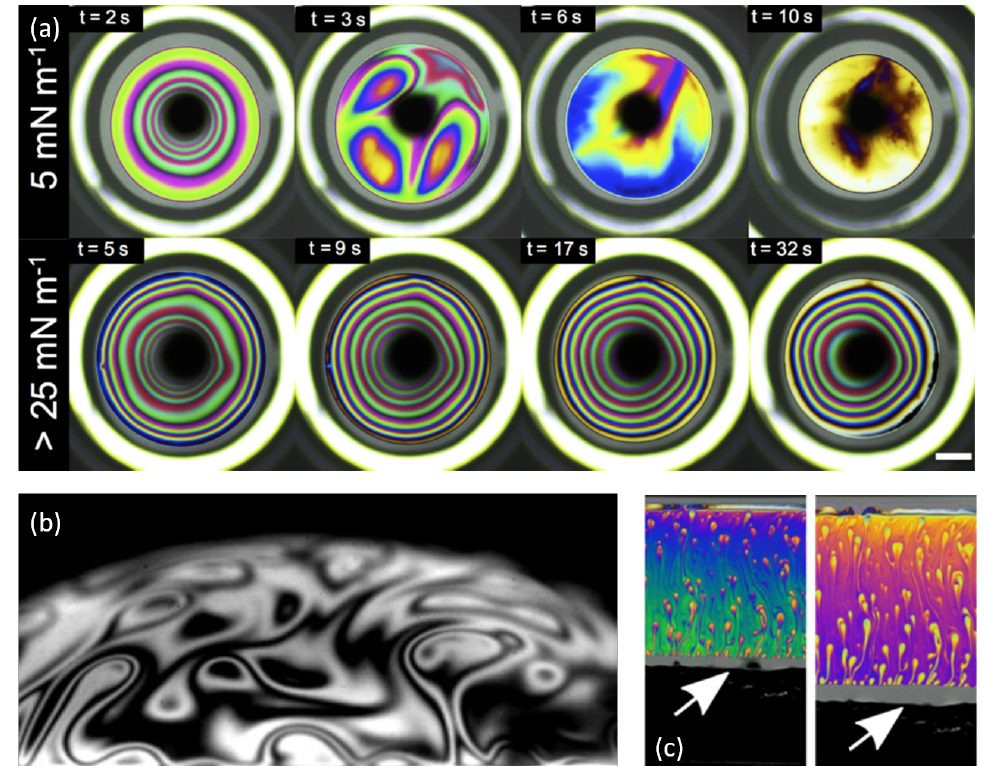
Figure 5. ( a ) Top view of a bubble thinning along time. The bubbles are stabilised by DPPC. The experi- ment allows to control accurately the surface pressure, which is set to 5 mN m − 1 (top) or to 25 mN m − 1 . The former exhibits some loss of axisymmetry. Figure adapted from reference [42]. ( b ) View of the marginal regeneration patches in the meniscus of a surface bubble. Figure adapted with authorization from reference [21]. ( c ) Observation of marginal regeneration patches rising at the surface of vertical foam film during its extension at a controlled velocity. The white arrow indicates the position of the frame used to extend the foam film. Figure adapted with authorization from reference